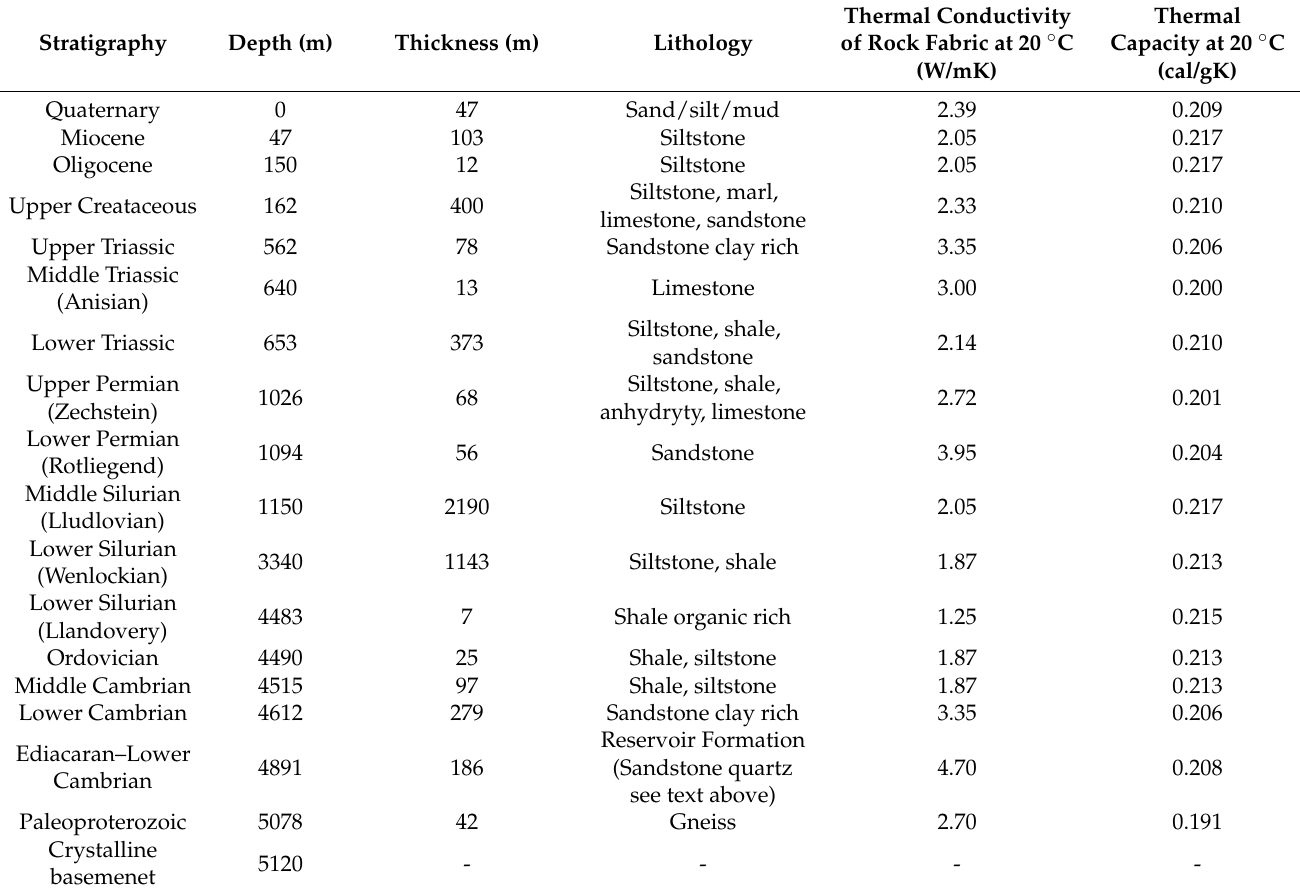
Table 1. Lithostratigraphic column of the Słupsk IG-1 well with thermal parameters to 1D and 2D modelings. Lithology after PertoMod library